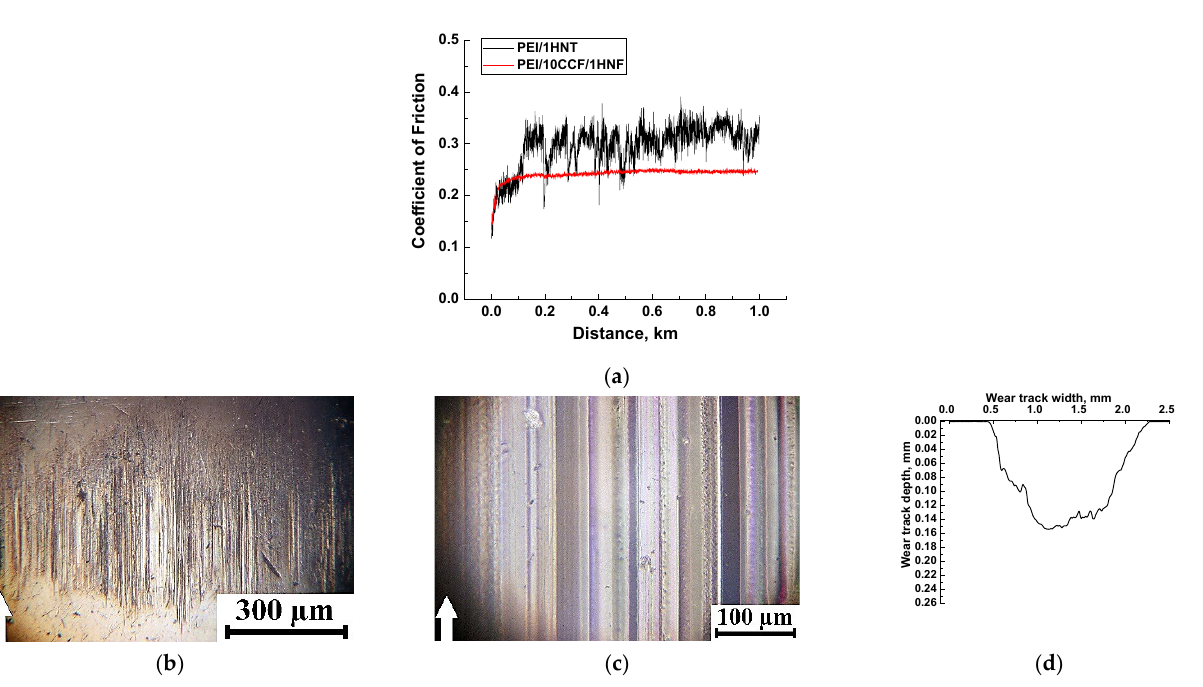
Figure 14. The time dependence of the CoF values for the PEI/1HNT nanocomposite ( a ), optical photographs of the steel counterpart surfaces ( b ), the wear track ( c ) and the wear track profile ( d ) after the tribological tests of the PEI/1HNT ( d ) nanocomposite. Point tribological contact.